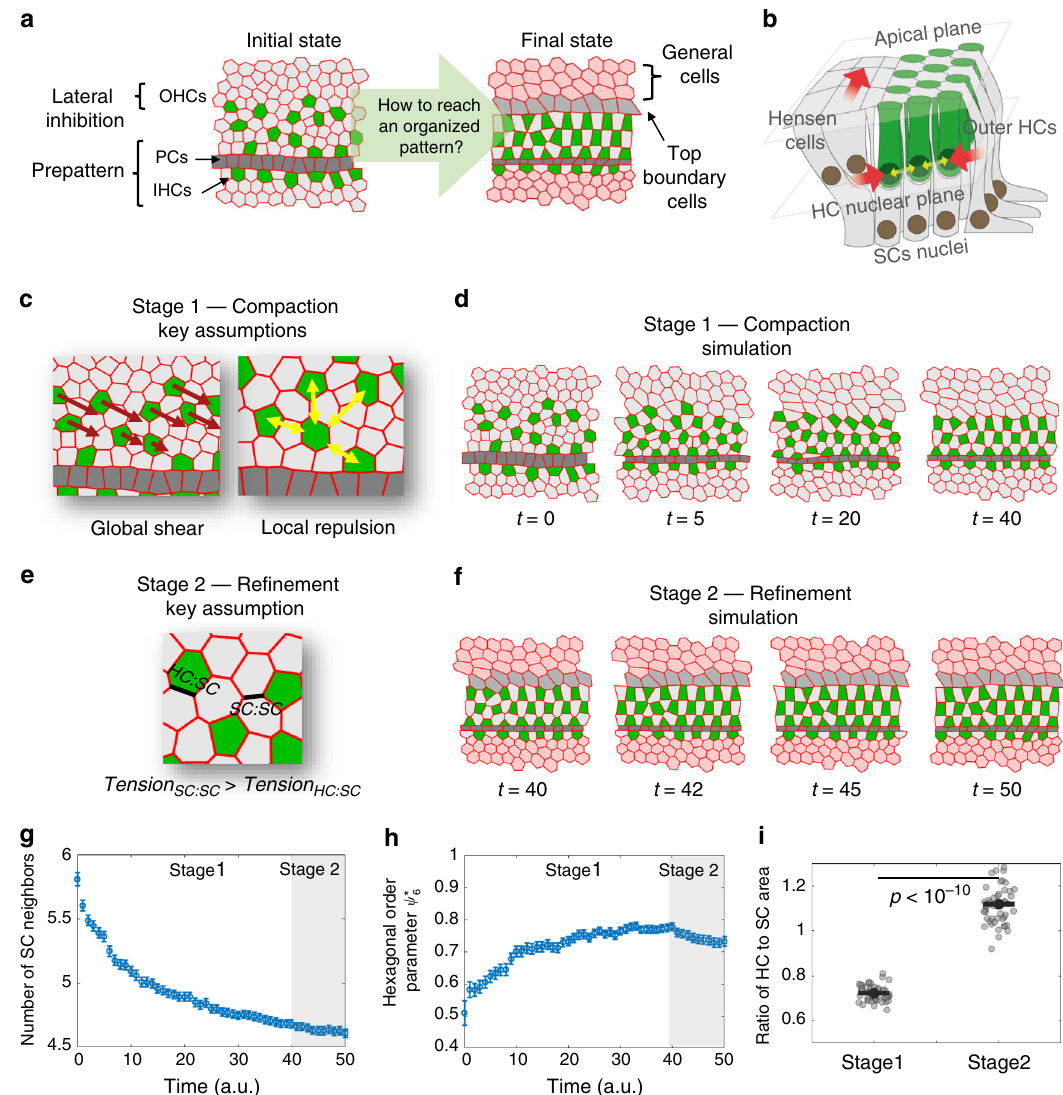
Fig. 3 A mechanical model based on global shear and local repulsion explains patterning of the OHCs. a Schematic of the initial state of the model and the desired fi nal state. The initial state for the simulation begins with the IHCs and pillar cells already pre-formed. A lateral inhibition mechanism is used to de fi ne a disordered pattern of HCs and SCs at a certain distance from the pillar cells. b Schematic of the three-dimensional structure of the organ of Corti